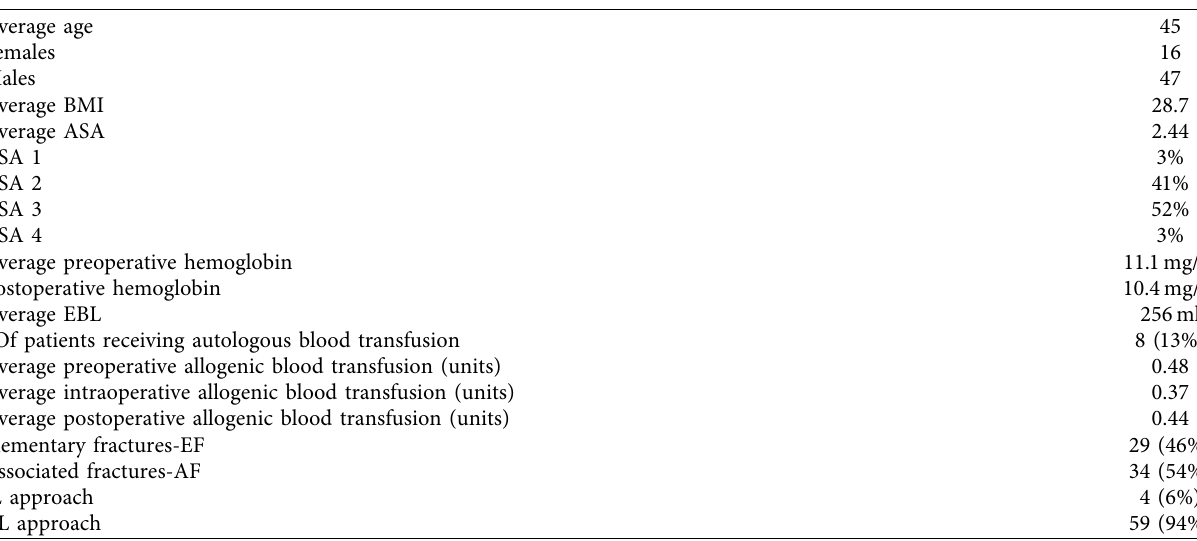
Table 1: Patient data including age, gender, BMI, ASA, pre- and postophemoglobin in mg/dl, average EBL, number of autologous transfusions, average units of autologous blood transfused, average number of units pre- and postallogenic transfusions, fracture patterns, and surgical approach. IL � Ilioinguinal, KL � Kocher-Langenbeck, ASA � American Society of Anesthesiology Score, BMI � body mass index, EBL � estimated blood loss, EF–elementary fracture pattern, AF � associated fracture